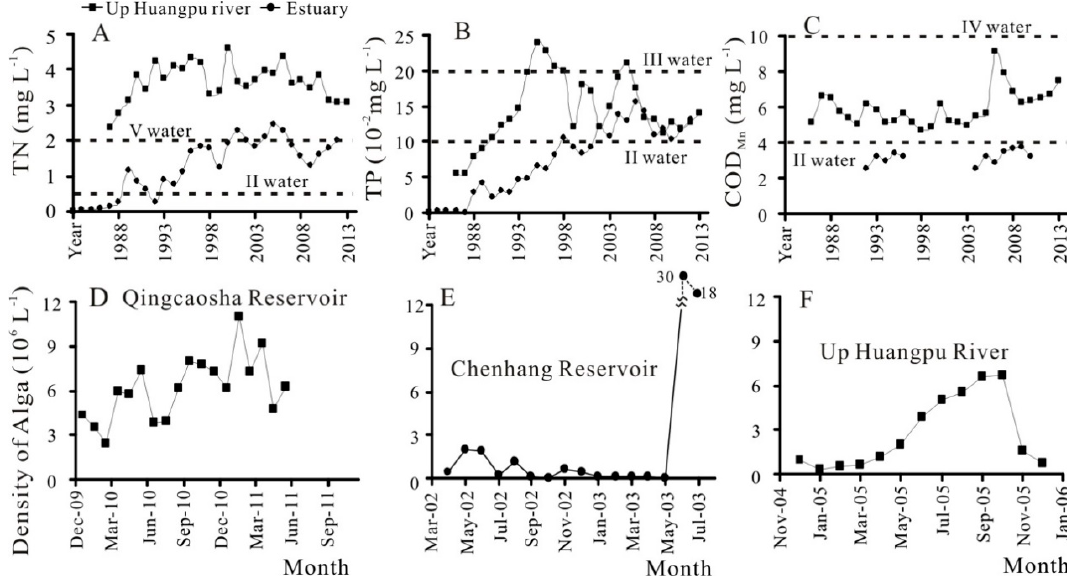
Figure 3. Eutrophication variations in the Changjiang Estuary and the Huangpu River. ( A )